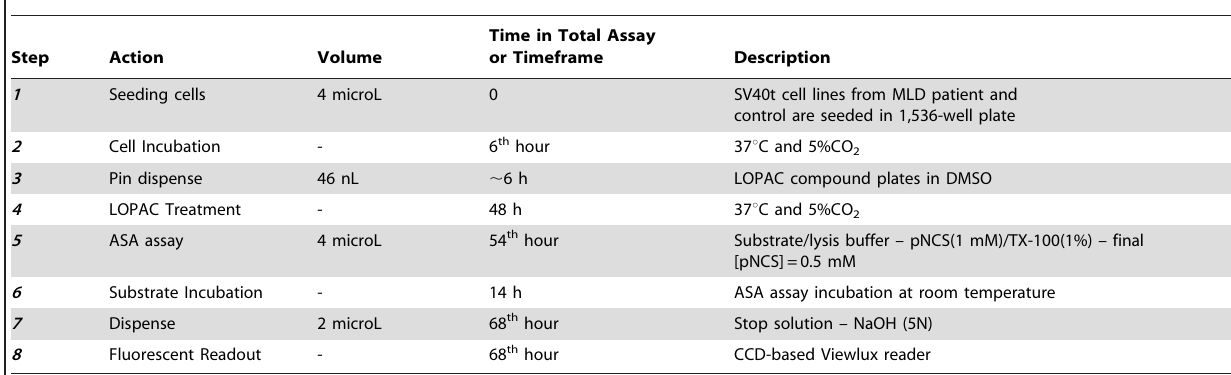
Table 1. Cell-based HTS assay for ASA